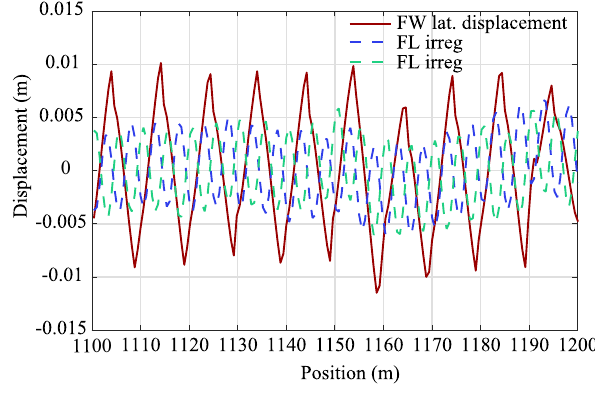
Fig. 10 Simulation with gauge variations with 5 mm amplitude and 5 m wavelength in the interval 1100–1200 m. The figure is a zoomed- in version of Fig.